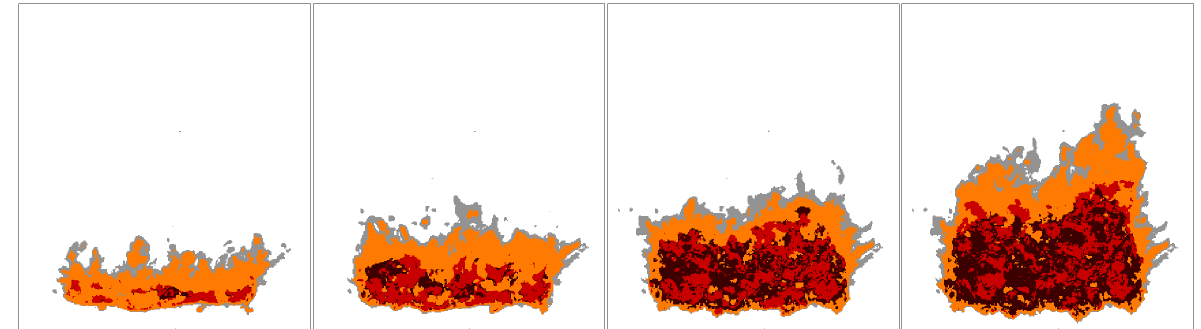
Figure 6. Regions from the frames in the bottom row of Figure 2 that are heating (gray), fully combusting (between the ignition and maximum temperature, orange), and cooling (red and dark brown). Fuels in the dark brown region are still undergoing combustion but have cooled below 550 ◦